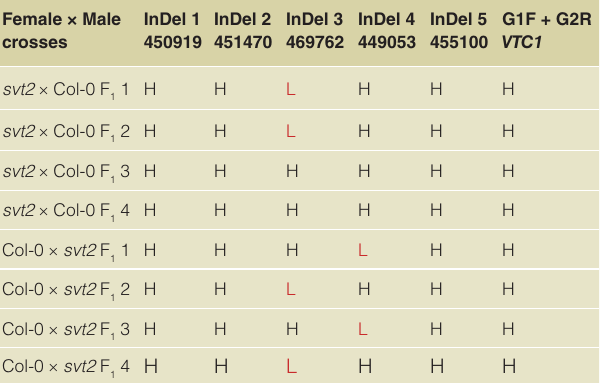
back to svt2 -like plants (Table 3, Table 4; Figure 8, Figure 9). (4) We were unable to obtain true F heterozygotes in all svt2 / 1 Col-0 reciprocal crosses (Table 5). (5) Delayed flowering and enlarged morphology phenotypes argue against the fact that svt2 is a result of a L er -0 wild-type seed landing on the flat during the